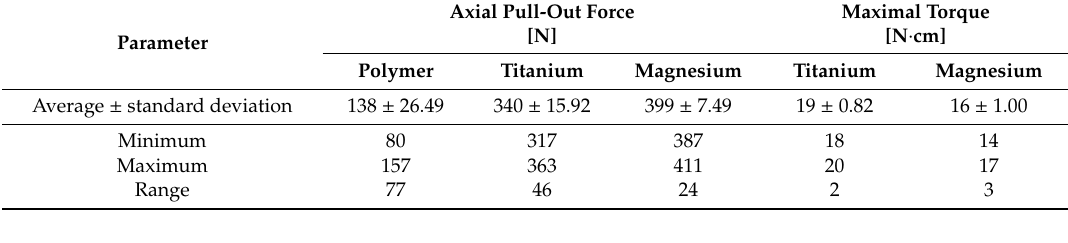
Table 2. The axial pull-out strength of three types of mandible head osteosynthesis screws and the torsional properties of the metallic bone screws.